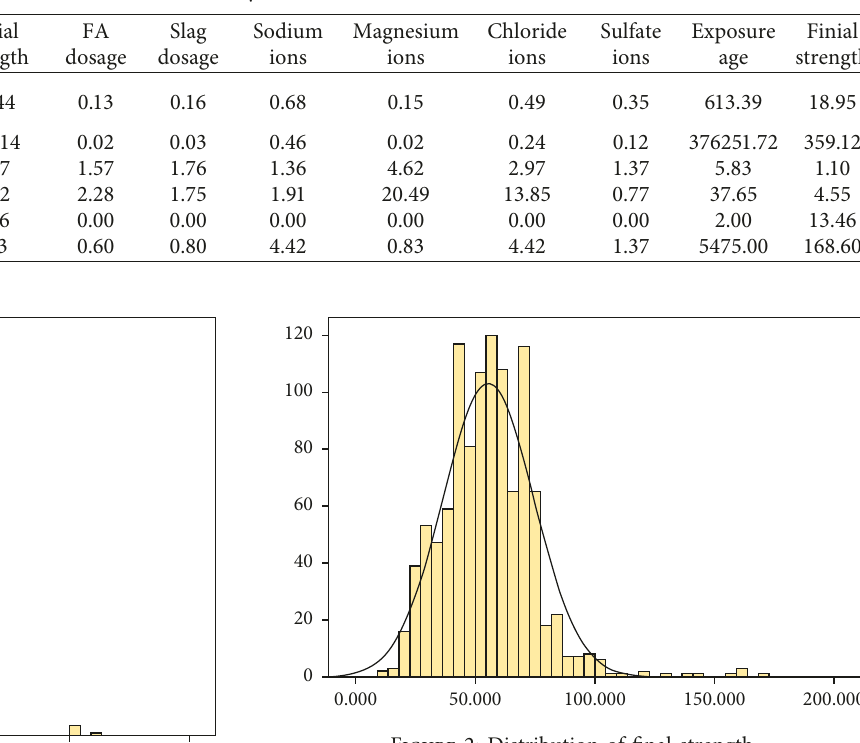
Table 2: Statistical analysis of 1078 sets of data.